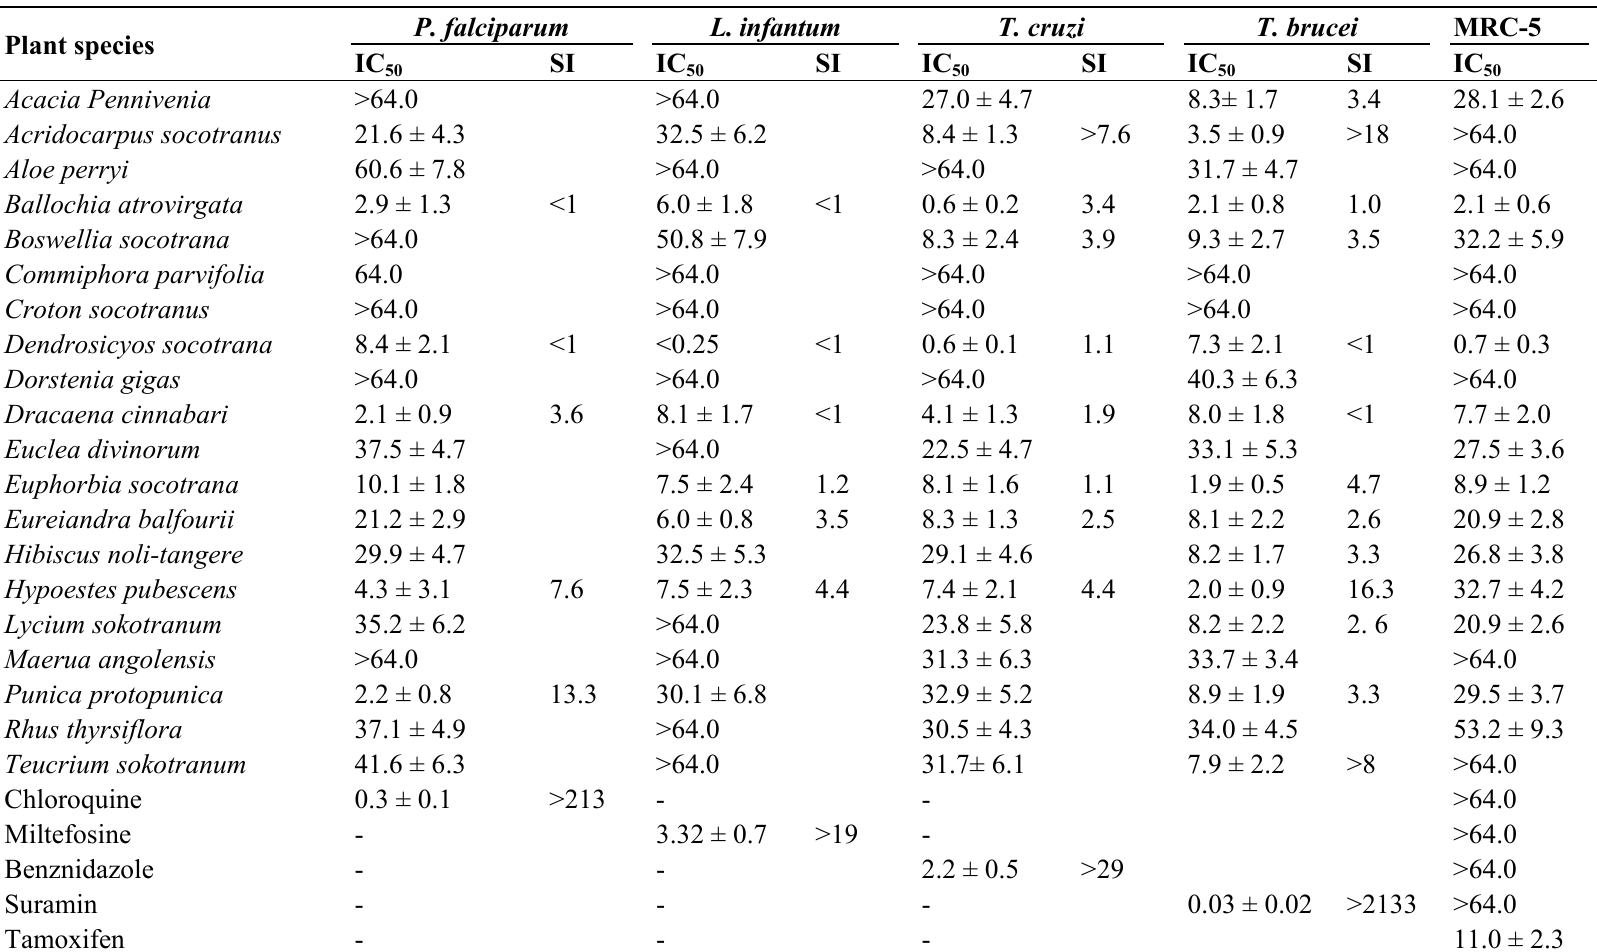
µg/mL) of the methanolic extracts of the investigated plants. 50